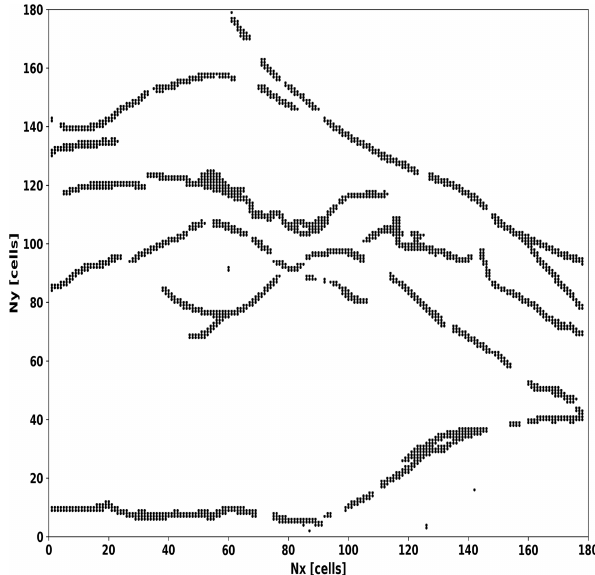
Figure 1. Map (azimuthal view) of the Northridge fault system. It is digitalized to include in our computing domain where each pixel of the map corresponds to a cell ( x,y ) in our